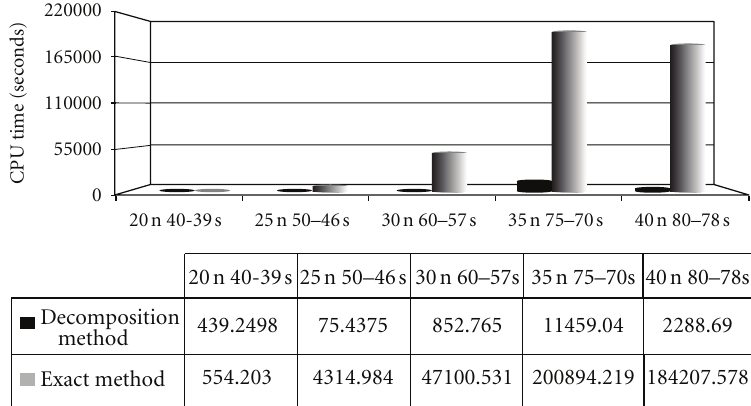
Figure 13: Comparison of CPU time between decomposition method and exact